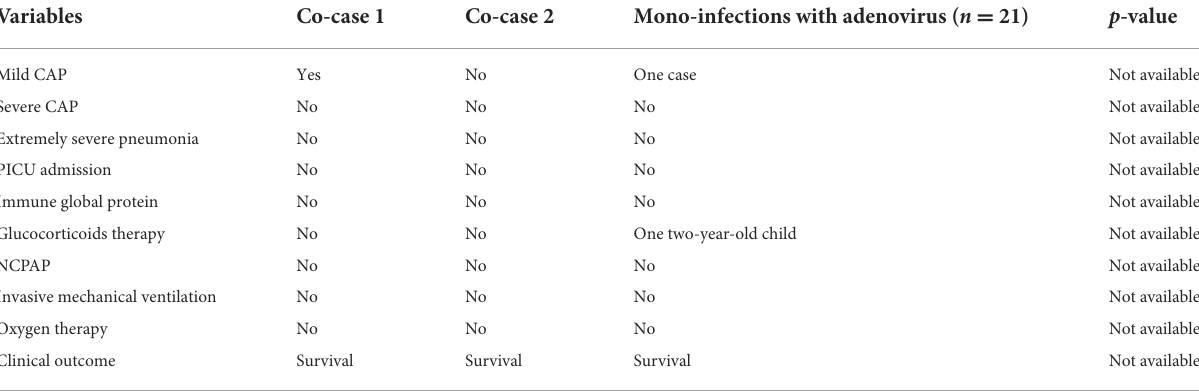
TABLE 3 Treatment and disease severity of two children coinfected with HCoV-229E and adenovirus admitted to different rooms of the same pediatric ward and mono-infections with adenovirus in Lishui, Zhejiang Province, July–August